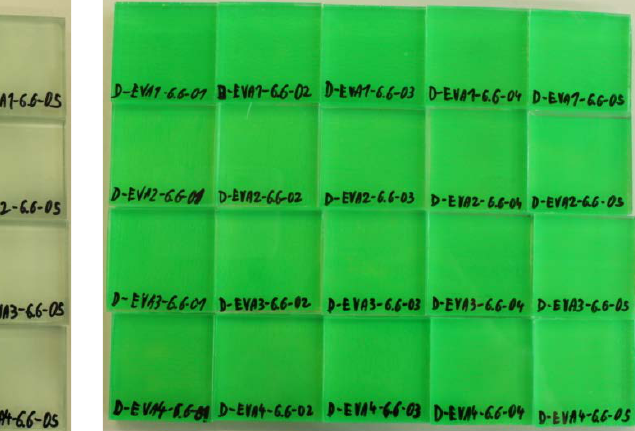
Fig. 11 Samples for the shear test with sprayed paint Fig. 12 Samples for the shear test with brush applied paint